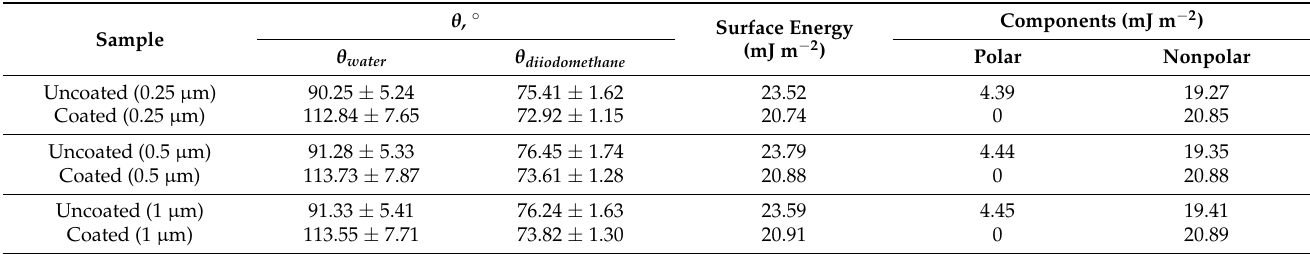
Table 1. Contact angle, surface energy, and component contribution of uncoated and coated samples.